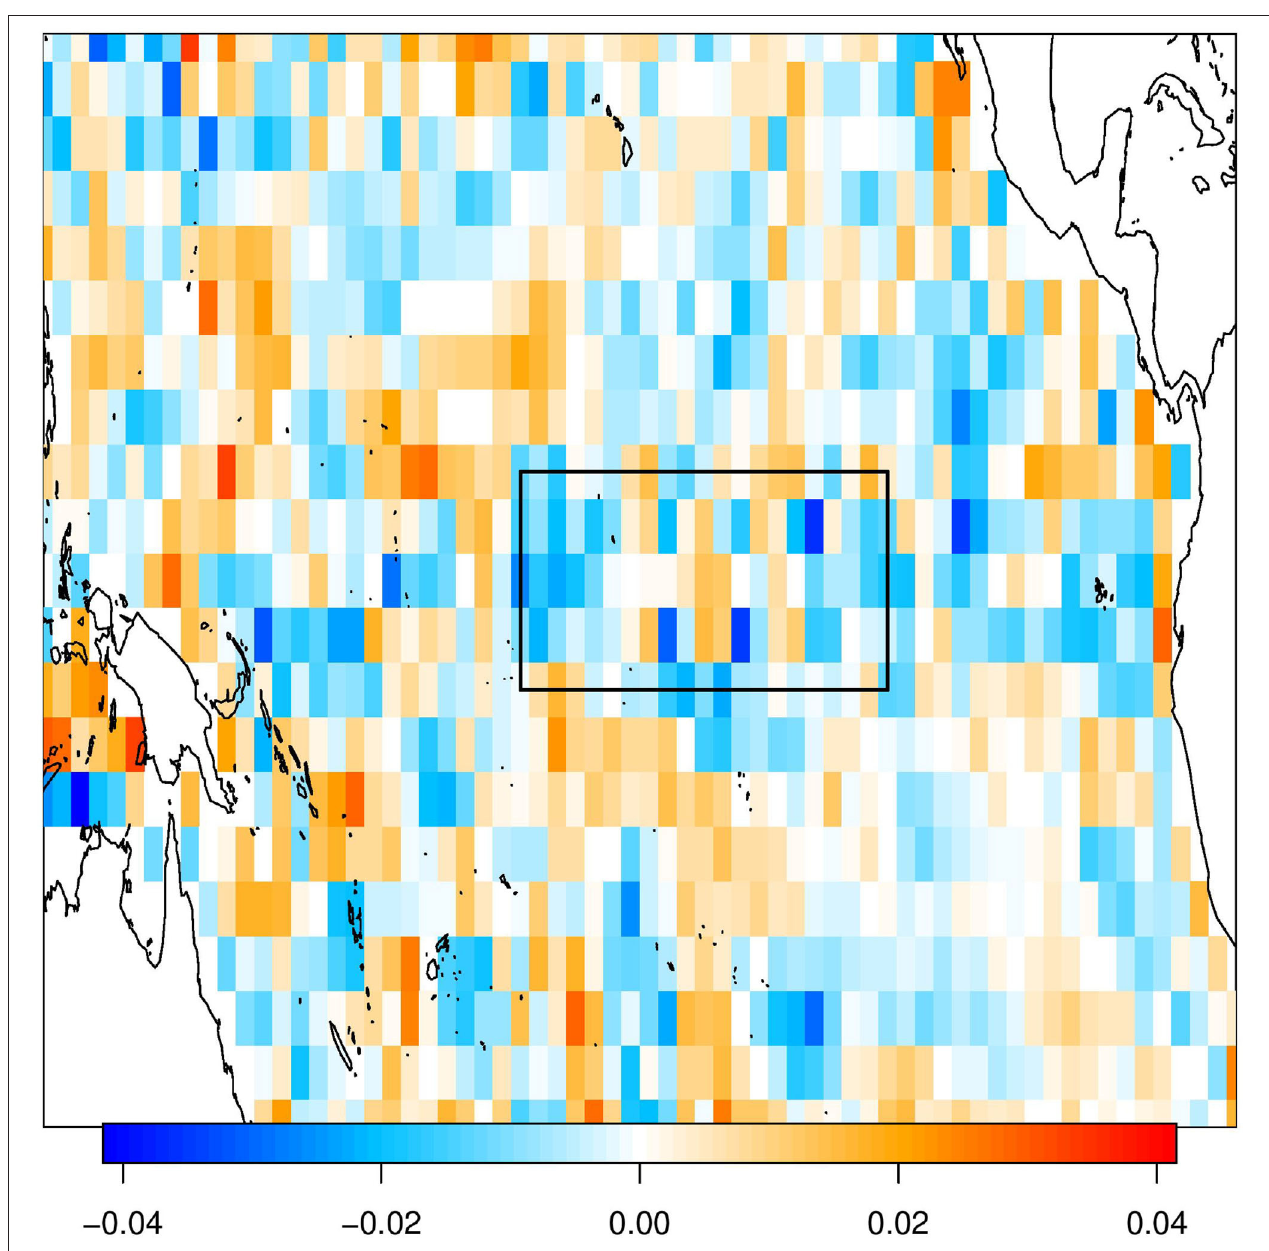
FIGURE 7 | A contrived example of β coefficients that yield predictions with a high correlation with the Nino3.4 index (0.95) while bearing little similarity to the leading EOF of